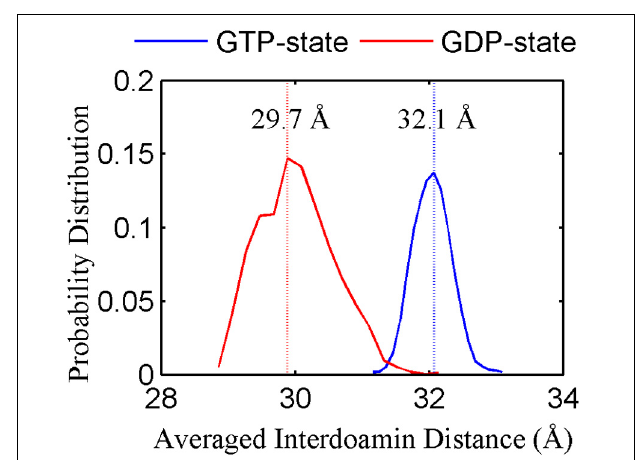
FIGURE 7 | The inter-domain distance distributions for the GTP- (blue) and GDP-bound (red) states. In all the cases, the distances are calculated by averaging all the GTP-bound (two runs) or GDP-bound (three runs) trajectories.